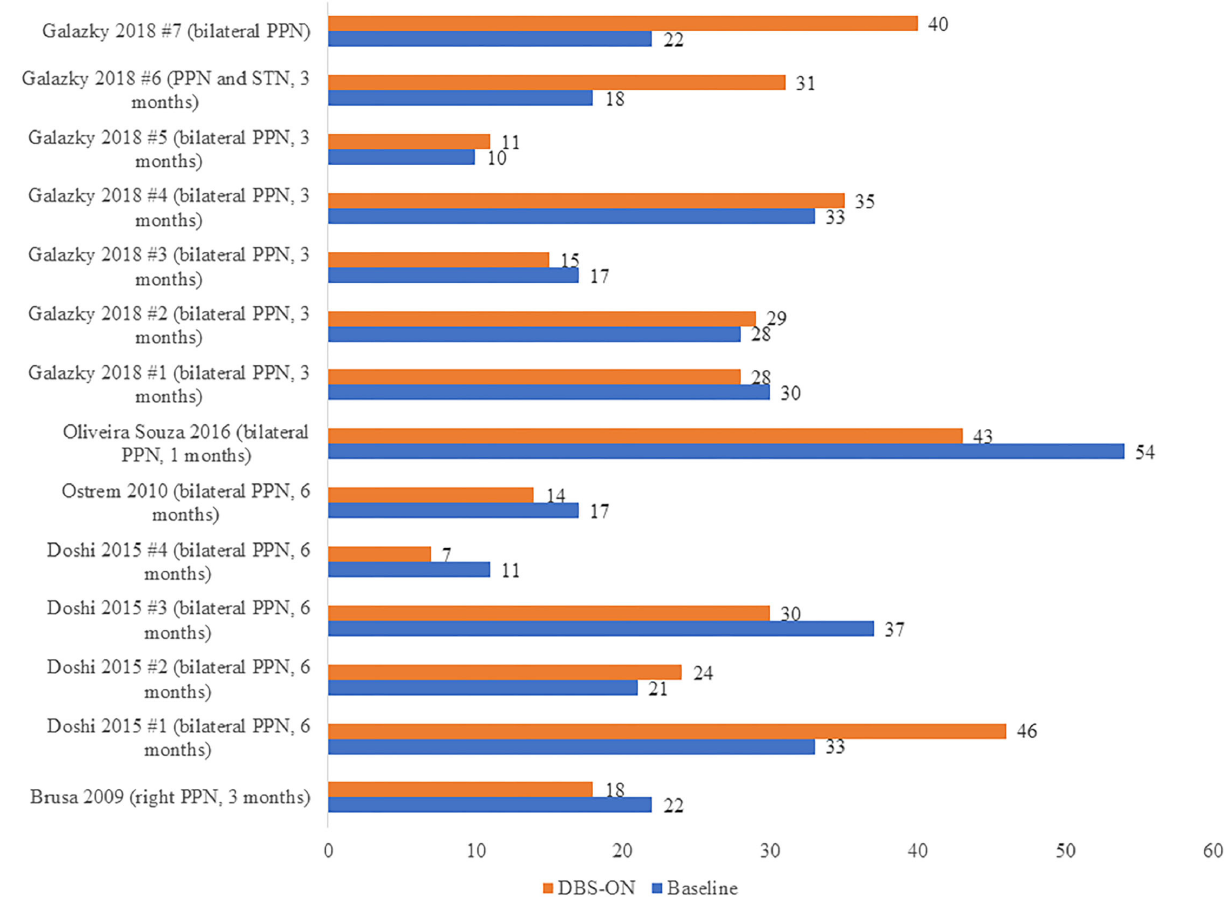
FIGURE 3 | UPDRS III scores in PSP patients before DBS (Baseline) and after DBS (DBS-ON). The words in brackets are DBS targets and postoperative time point at which the “DBS-ON” assessment was performed in each